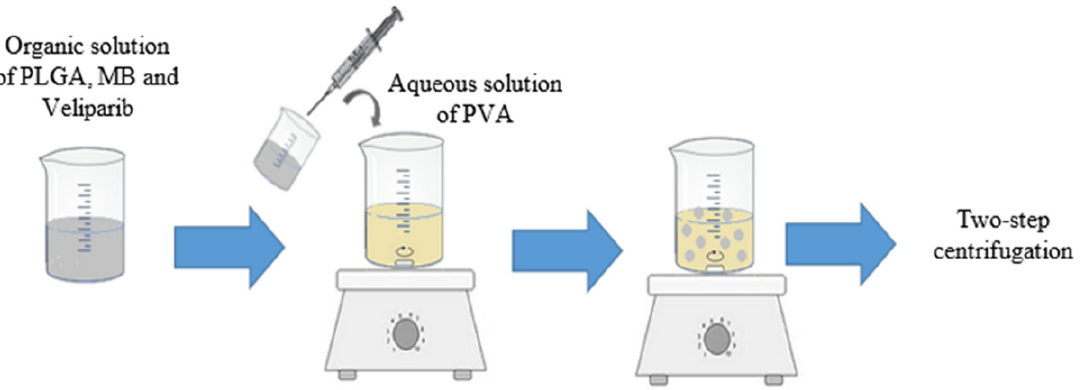
Figure 1. Synthesis of methylene blue and veliparib co-encapsulated into PLGA NPs (VMB-NPs) by using an adaptation of the nanoprecipitation method.